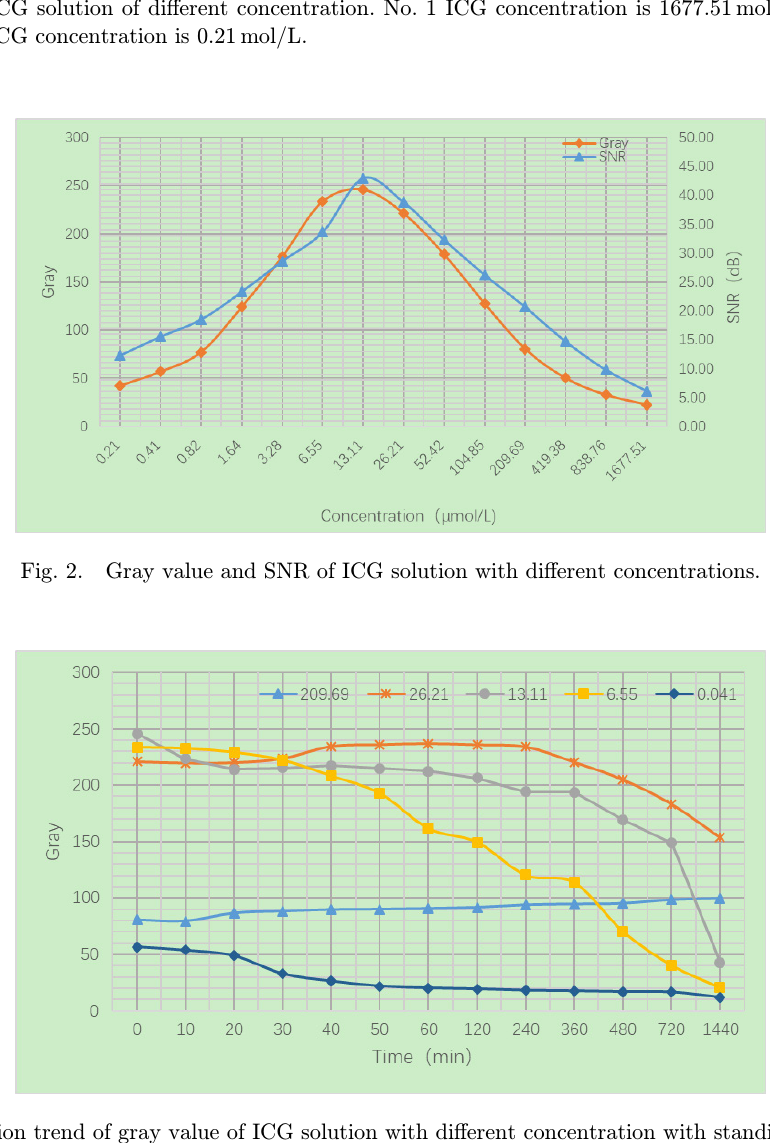
Fig. 3. Variation trend of gray value of ICG solution with di®erent concentration with standing time in vitro 3.2. The penetrating depth when the concentration was greater than 26.21 (cid:1) mol/L. Figure 3 recorded the trends in 1.5% agarose gel with di®erent ICG concentration gray values of ¯ve di®erent concentrations of was placed under the imaging system at the same ICG (0.041 (cid:1) mol/L, 6.55 (cid:1) mol/L, 13.11 (cid:1) mol/L, time. The image was recorded immediately (Fig. 4). 26.21 (cid:1) mol/L, 209.69 (cid:1) mol/L) in 24 h.